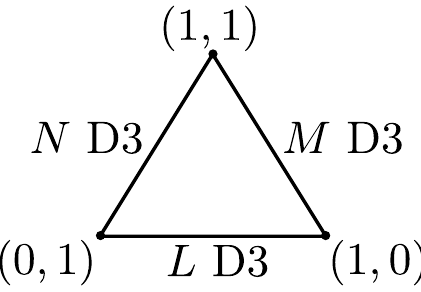
Figure 13 . A D5-, an NS5- and a (1 ; 1)-brane joined by N , M , and L D3-branes. This brane con(cid:12)guration produces an N = 4 Yang-Mills theory with three half-BPS defects, which upon topological twisting is supposed to give a 3d TQFT. Teichm(cid:127)uller TQFT is the special case with N = M = 0 and L =